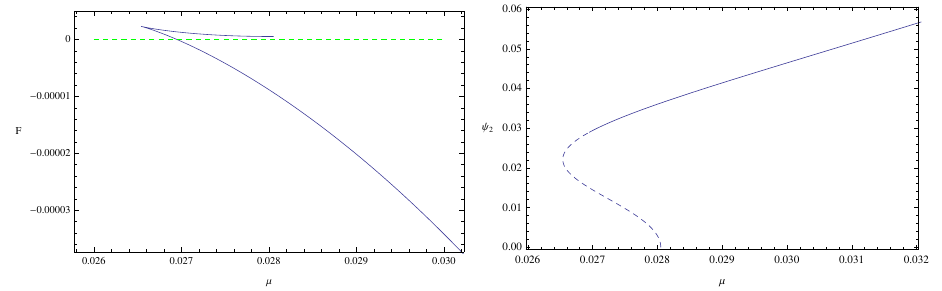
Figure 5 . (Color online) The two panels are with q = 100, m 2 = − 2 and C 4 = 0 . 1. We show behaviors of free energy of boson star phases with solid blue line in the left panel and the dashed green line of F = 0 in the left panel is with the flat space. We also show behaviors of ψ 2 in the right panel. In addition, the solid blue curve in the right panel represents the stable phases and the dashed blue line in the right panel corresponds to unstable phases.